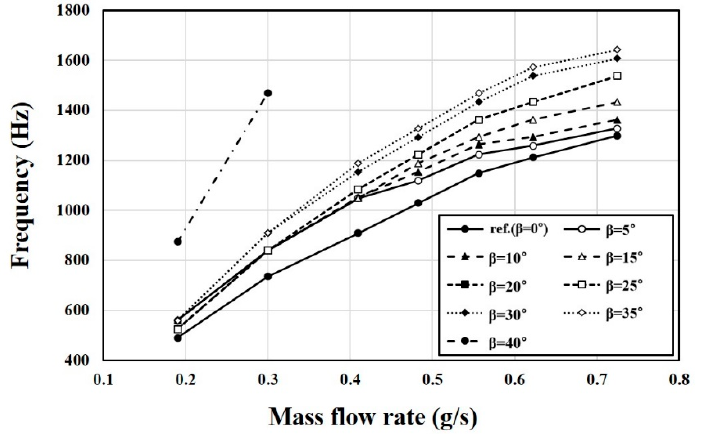
Figure 9. Frequency variations with mass flow rate for various bending angles ( β ).